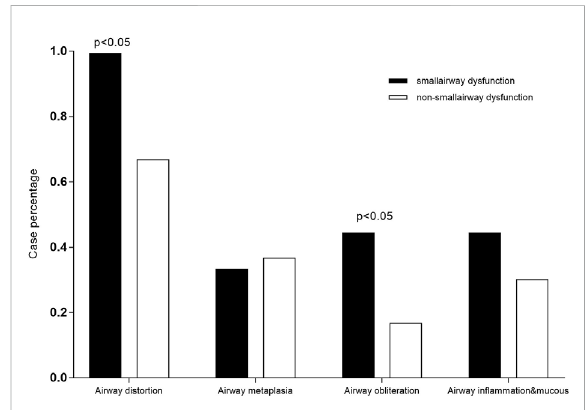
FIGURE 4 Comparisons of pathological characteristics between the SAD and non-SAD groups The pathological lesion types of airway distortion proportion and airway obliteration proportion were signi fi cantly high in SAD patients.